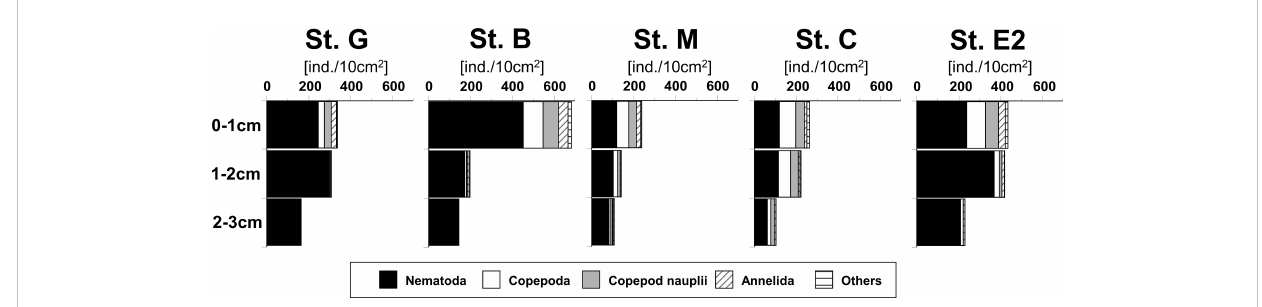
FIGURE 3 Vertical pro fi les of cumulative mean abundances of main meiofaunal taxa in the sediment at fi ve stations in the southeastern Bering Sea. “ Others ” contain taxa with frequencies< 1% such as Kinorhyncha and Ostracoda. Details of densities of all meiofaunal taxa in each sediment layer of all core samples are shown in Table S1.